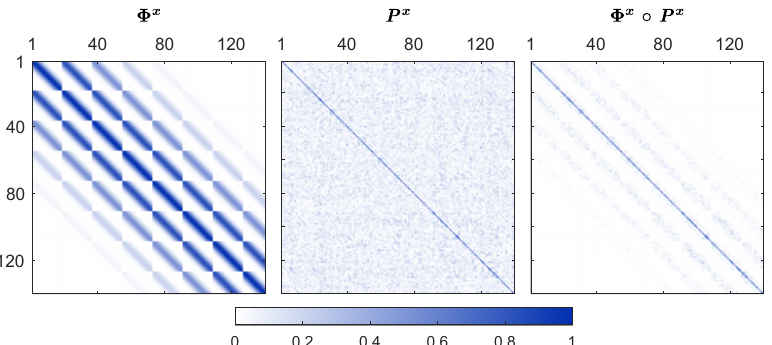
Figure 2. Long-range spurious correlations arise in the case where a covariance matrix is described by a small number of particles. Using physical knowledge of the system, these undesired correlations can be corrected. (cid:56) x is the localization matrix. Applying localization, the covariance of physically nearby states are multiplied with a value close to 1, and the covariance of physically distant states are multiplied with a value close to 0. In our example case, this results in the localized covariance matrix (cid:56) x ◦ P x , where ◦ is the element-wise